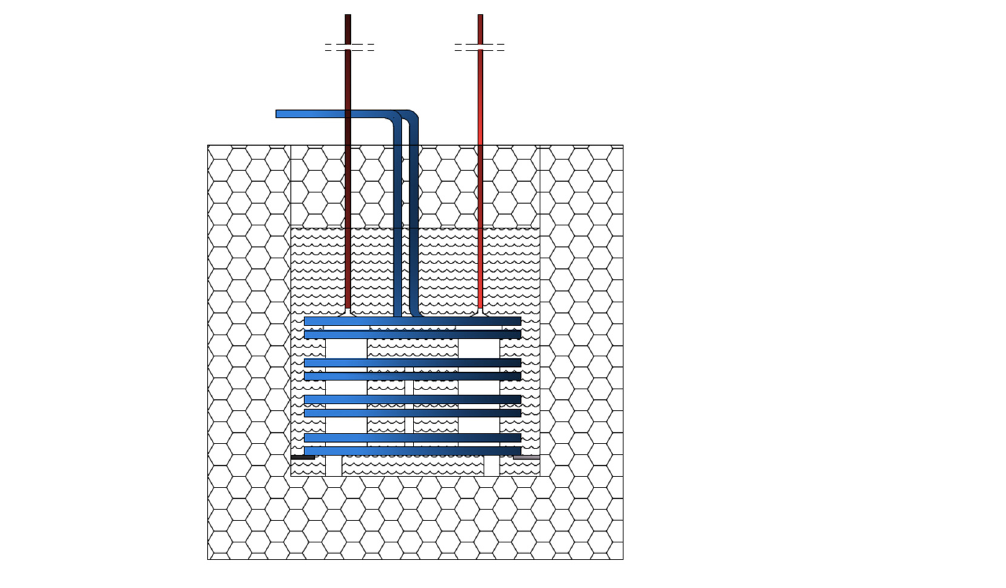
Figure 3. Diagram of an external measuring system [16].